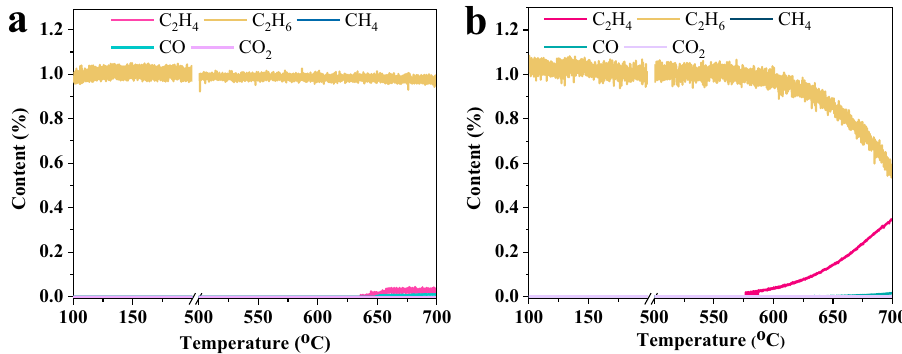
Fig. 3 Ethane TPSR. a 0.7Ni@NaY and b 3Ni/HY,